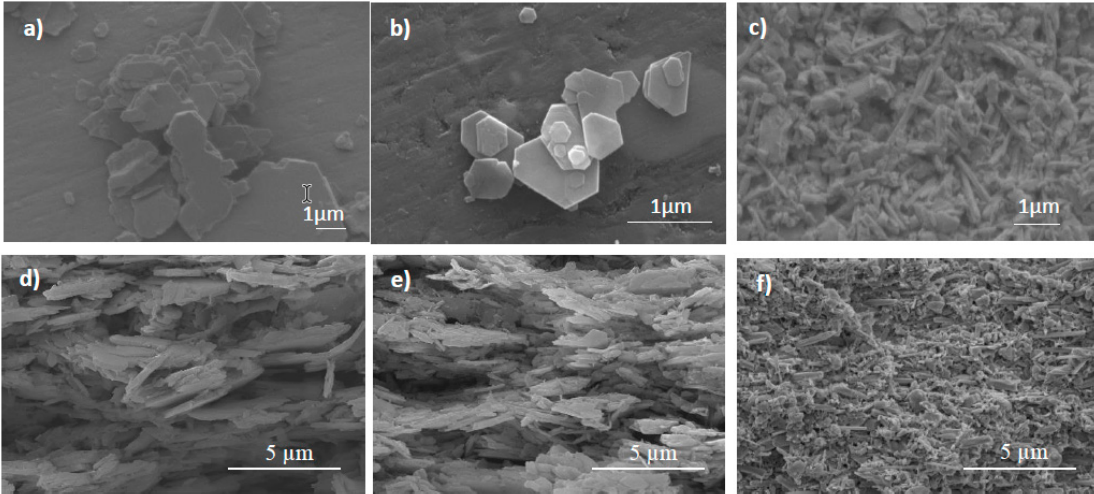
Figure 2. ( a–c ) SEM observations of KRG, KCS, and H powders respectively; ( d–f ) SEM observations Figure 2. ( a – c ) SEM observations of KRG, KCS, and H powders respectively; ( d – f ) SEM observations of KRG100, KCS100, and H100 green body respectively . of KRG100, KCS100, and H100 green body respectively.